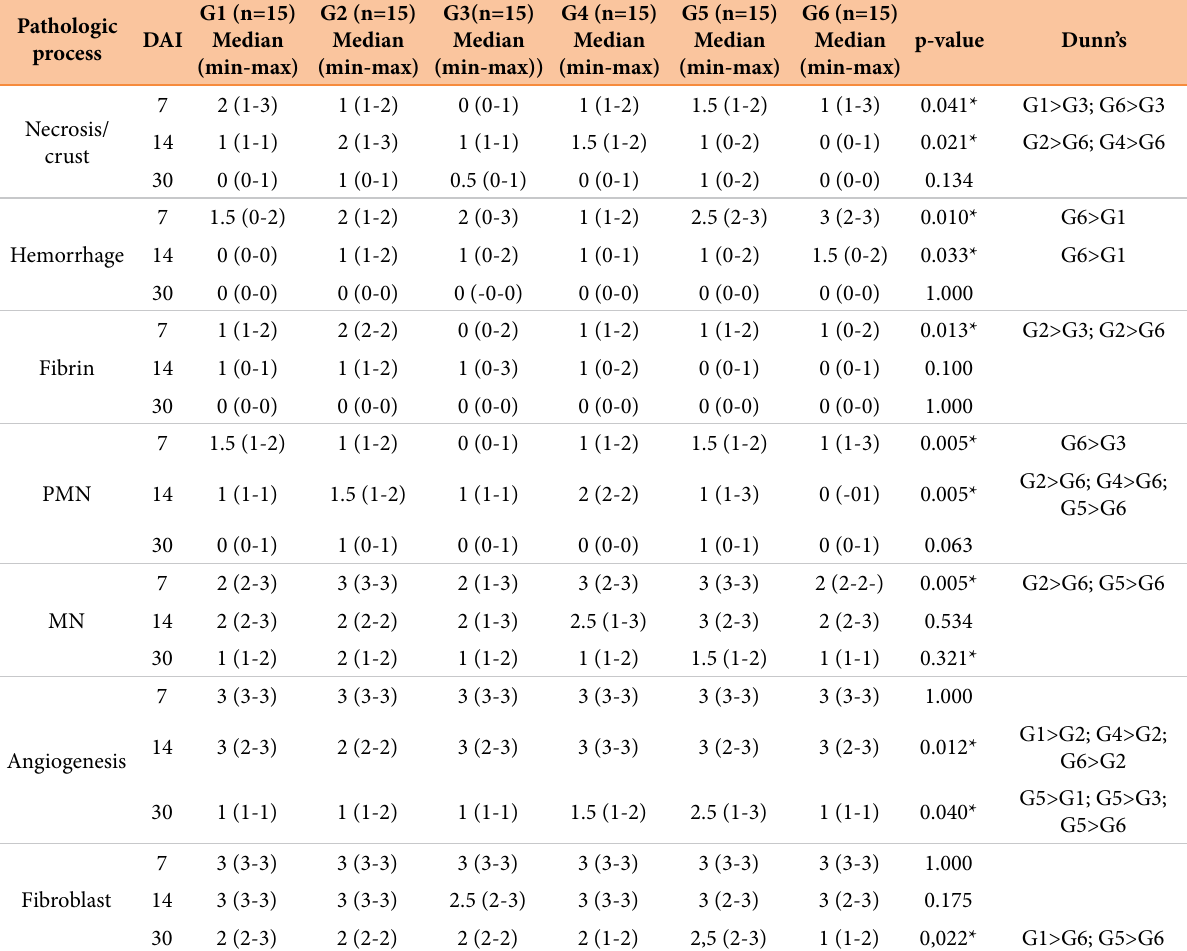
Table 3 - Microscopic analysis of partial thickness burn wounds experimentally induced in Wistar rats treated with calcium and/or sodium alginate hydrogel-based dressings #